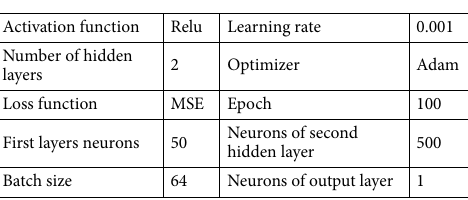
Table 3. LSTM hyperparameters.